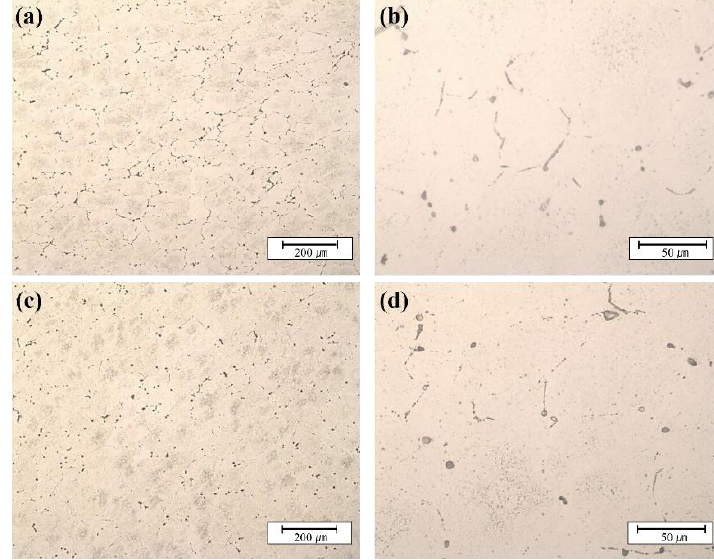
Figure 8. Microstructures of the D alloy observed by optical microscopy after forging ( a , b ) and microstructures after solution treatment of the alloy for 6 h plus following the forging ( c , d ). The uniformity of microstructures of alloy D was noticeably improved after solution treatment.